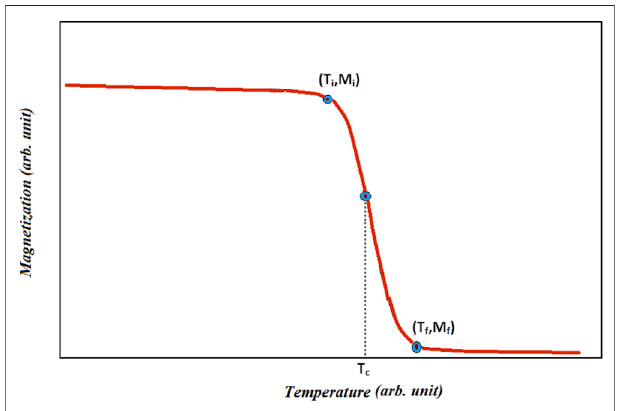
FIGURE 1 | Iso fi eld magnetization vs . temperature.